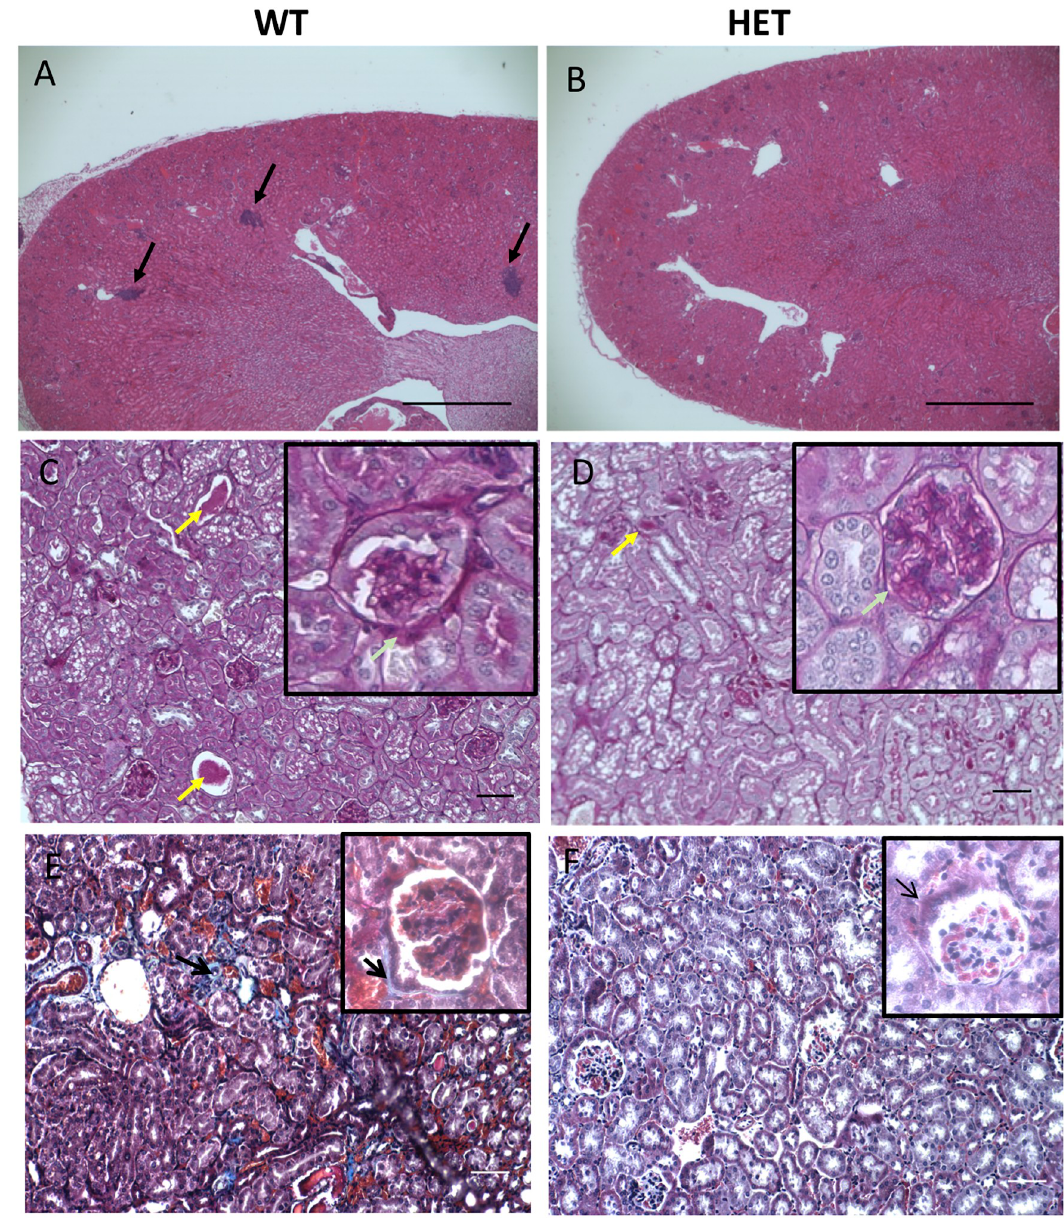
Fig 2. Histological differences in representative renal sections from age-matched WT (n = 6) and HET (n = 6) mice at 18 months. (A & B): Hematoxylin and Eosin staining in WT (A) and HET (B) kidneys showing evidence of increased inflammatory cell foci in WT (p = 0.0001) (Black arrows) as compared to HET animals. Original magnification 4X. Scale bar; 100 μ m. (C & D): Periodic acid-Schiff (PAS) staining showing larger and more numerous intraluminal proteinaceous casts in WT (C) as compared to HET (D) mice (yellow arrow). Insert shows glomerulonephropathy (thickening of Bowman’s capsule) in WT (green arrow) versus HET mice. (E & F): Masson-Trichrome staining of WT (E) and HET (F) kidney sections showing increased fibrosis indicated by the blue staining in WTs (Black arrows) as compared to HET mice. Original magnification for C, D, E and F: 20X. Scale bar; 50 μ m.